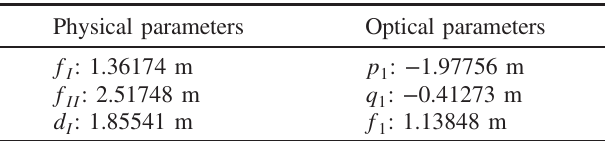
TABLE I. Parameters of the final focus doublet. Physical parameters Optical parameters